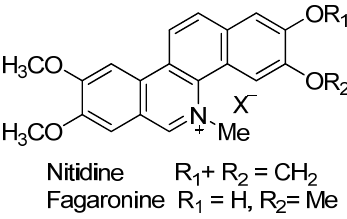
Figure 1. Structure of nitidine and